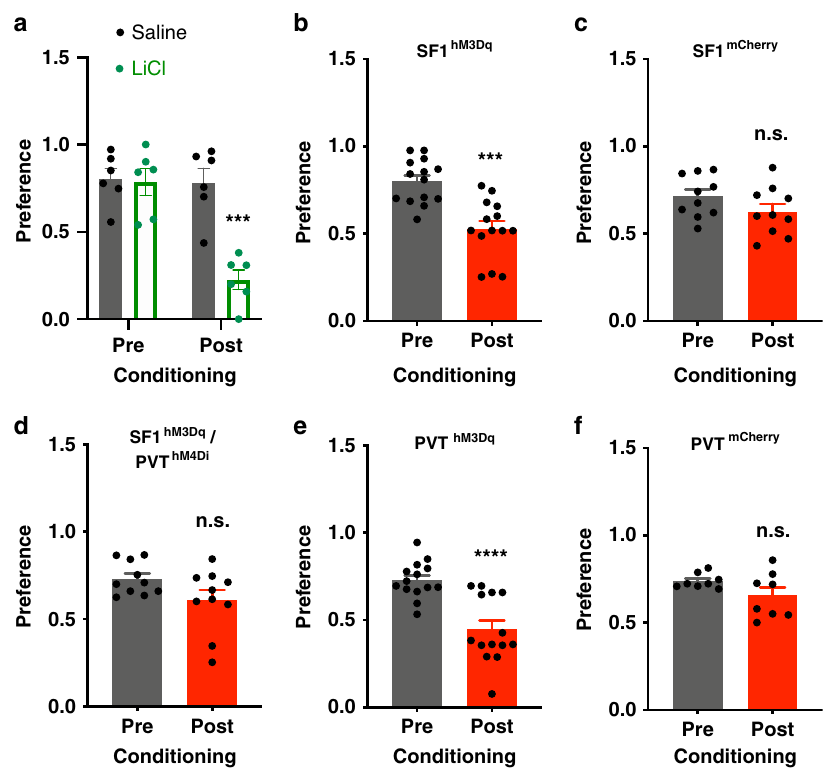
Fig. 8 SF1 neurons and their projections to PVT elicit fl avor aversion. a Mice treated with LiCl via i.p. injections showed aversion to the initially preferred fl avor as compared to vehicle-treated SF1-Cre mice ( n = 3 males and 3 females per group; post conditioning Saline vs LiCl, p = 0.0002). b – c DREADD activation of VMH SF1 neurons with J60 via i.p. injections induced fl avor aversive-like behavior in b hM3Dq-transduced mice ( n = 7 males and 7 females, p = 0.0003) but not in c mCherry-transduced control mice ( n = 5 males and 5 females). d Simultaneous inactivation of PVT neurons with J60 via i.p. diminished the SF1 aversive effect in SF1 neuron hM3Dq and PVT hM4Di-transduced mice ( n = 5 males and 5 females). e , f Activation of PVT neurons with J60 via i.p. injections elicited a fl avor aversive effect in PVT neuron e hM3Dq-transduced mice ( n = 7 males and 7 females, p < 0.0001) but not in f mCherry-transduced mice ( n = 4 males and 4 females). Two-tailed Student ’ s t -tests for a – f ; data represent mean ± s.e.m.; *** p < 0.001; **** p < 0.0001; n.s. not signi fi